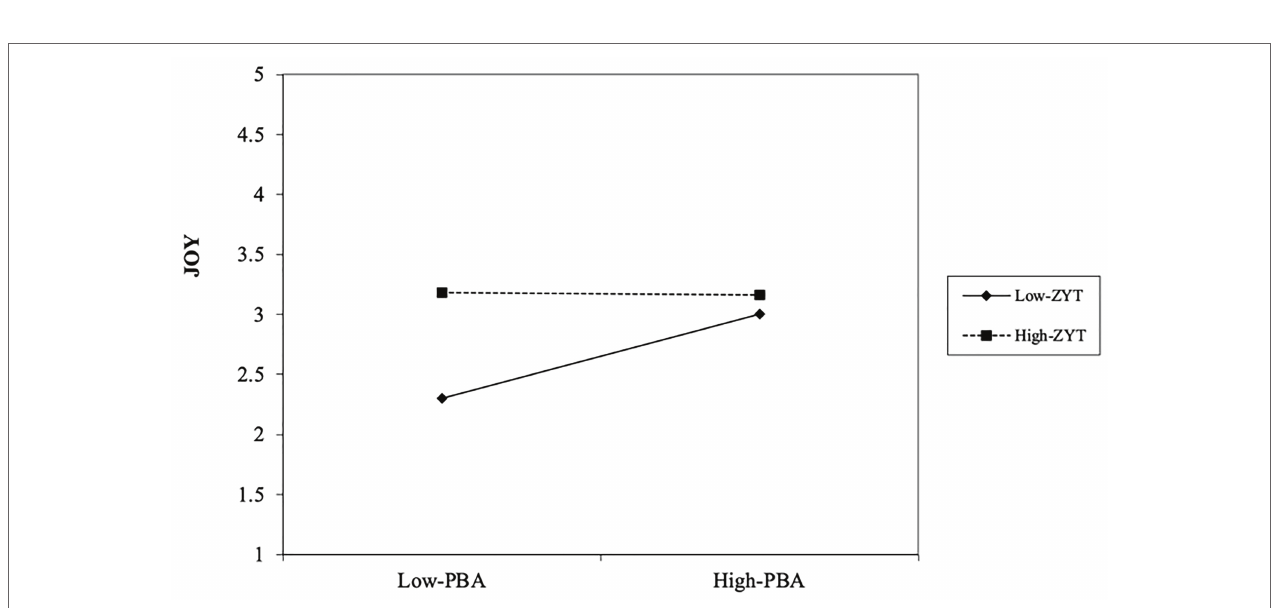
FIGURE 3 | Significant moderating effect of ZYT on the relationship between PBA and Joy. PBA refers to performance-based accountability, and ZYT refers to zhongyong